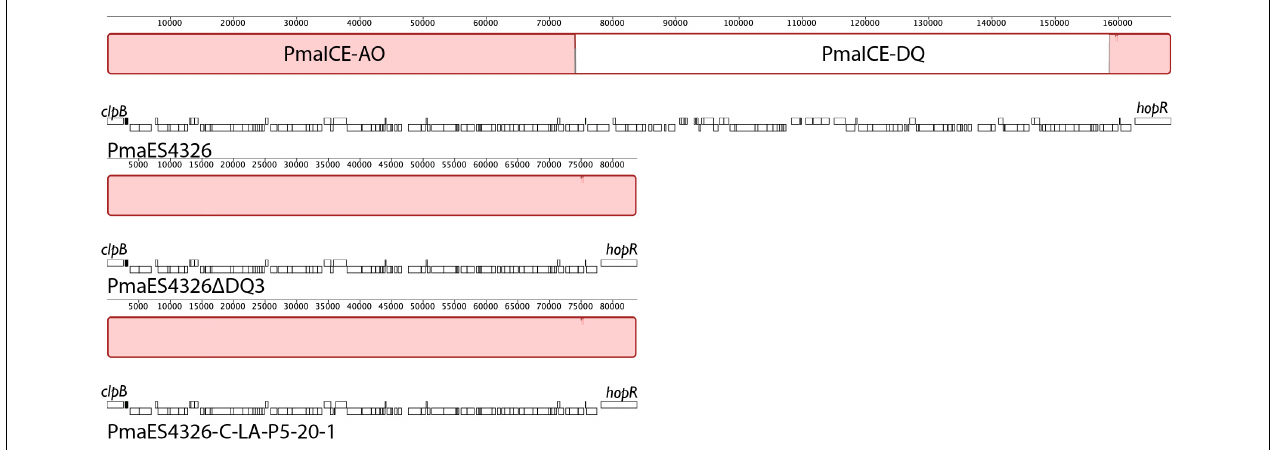
FIGURE 3 | Identical deletions of PmaICE-DQ following laboratory selection and passage under selective conditions in planta . We compared genomic regions bordering ICE-DQ in a strain where the region containing hopQ was intentionally deleted ( Pma DQ3) as well as a strain that arose after five passages in planta in N. benthamiana ( Pma LAP5-20). Genomic segments from each of the three strains are arranged vertically, with each line labeled by strain name and genes within each strain outlined in white boxes underneath the alignment. Each contiguous segment is oriented so that clpB is found on the left side of the segment and so that hopR is found on the right side. Sections within the alignment colored red are those that are aligned into contiguous blocks by Mauve and are shared by all three strains. A white section within the wild type Pma ES4326 alignment represents a region (PmaICE-DQ) that is not present in the other two strains. Mauve alignments of these regions demonstrate that identical evictions of ICE-DQ occurred in each